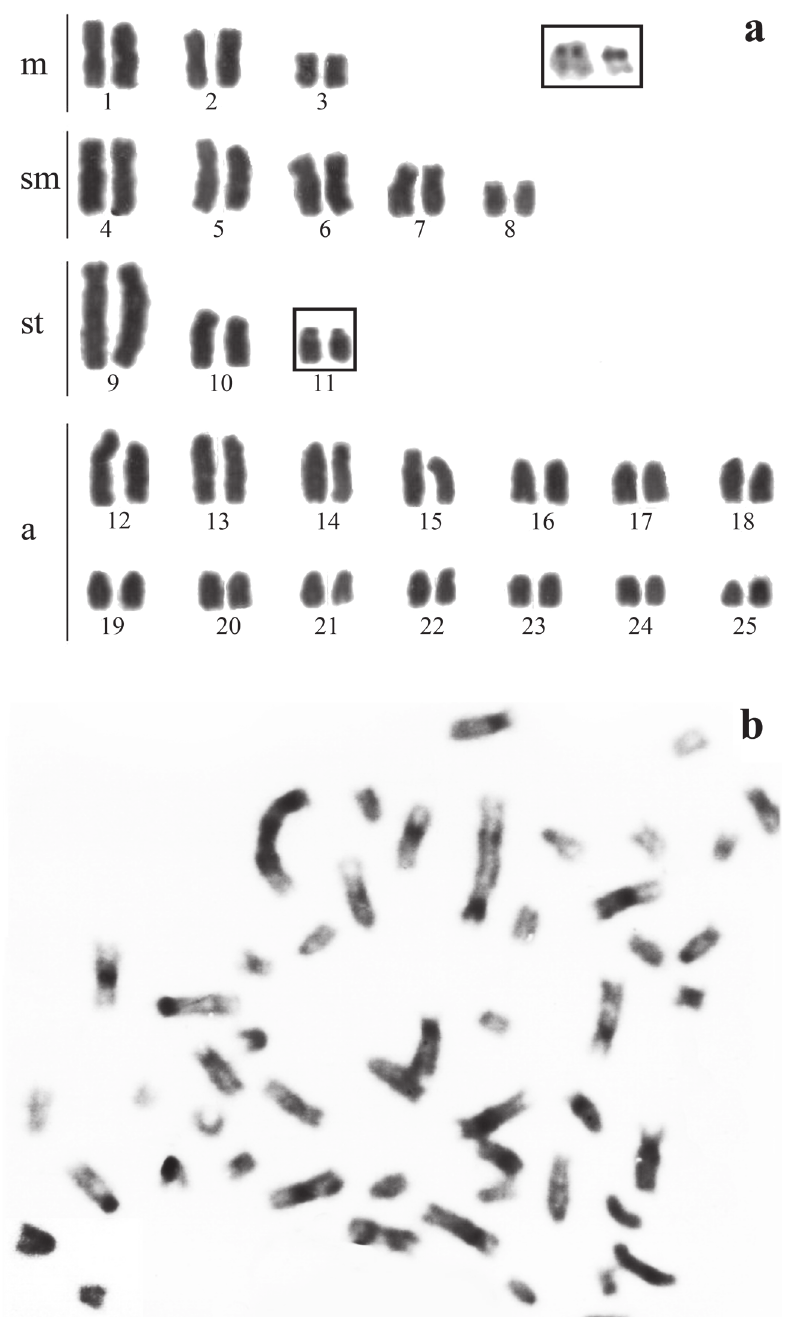
Fig. 1. Karyotypes with conventional Giemsa staining ( a ) and C-banding ( b ). Boxes display chromosomes bearing